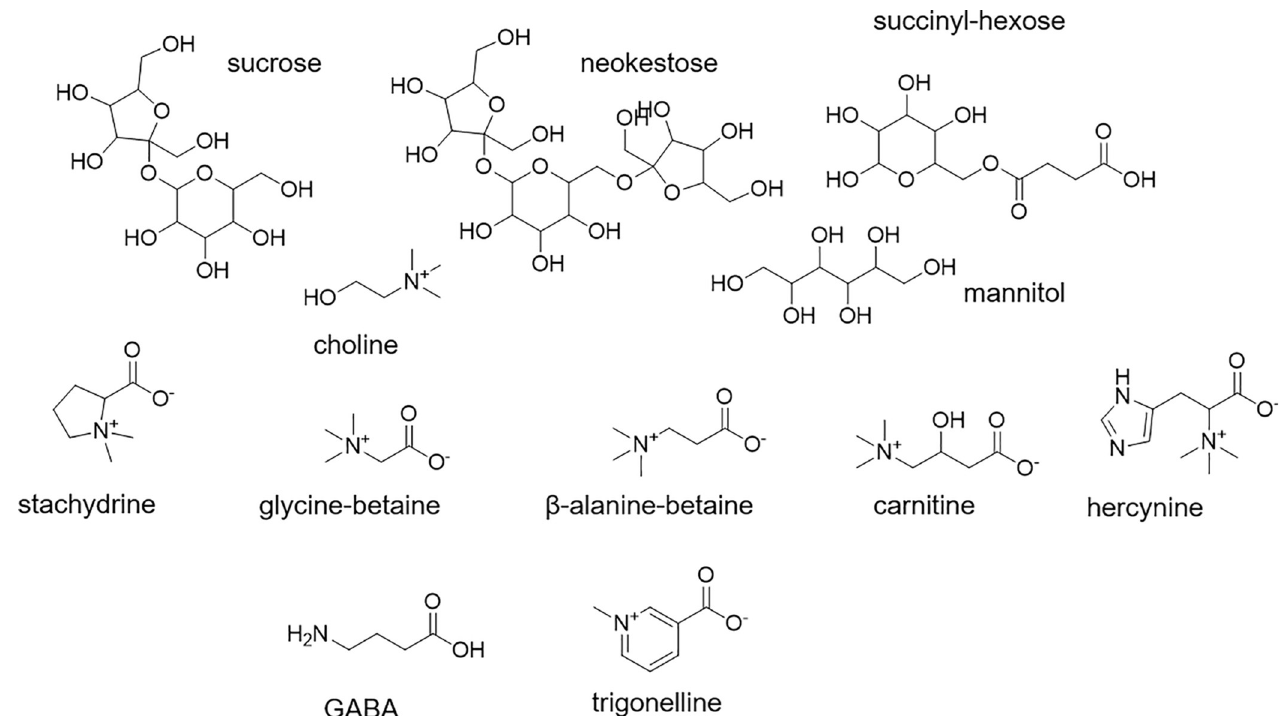
Fig 9. Chemical structures of select compounds that showed significant differences across the 2019 maple syrup production